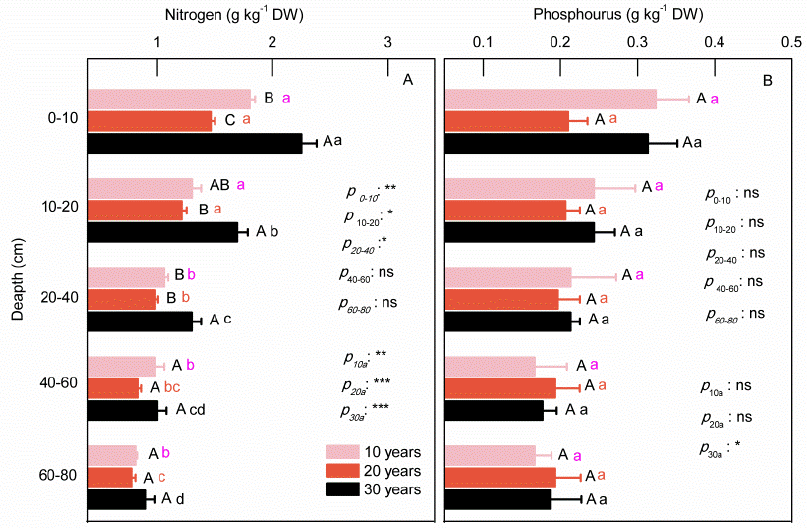
Figure 2. Concentrations of soil total nitrogen ( A ) and total phosphorus ( B ) of all Chinese fir plantations. The uppercase letters on the bars indicate significant difference between different aged plantations in the same soil layer, while the lowercase letters indicate significant difference among soil layers (0–10, 10–20, 20–40, 40–60, and 60–80 cm) in plots with same age. *, **, ***, and ns were indicated p < 0.05, p < 0.01, p < 0.001, and no significance, respectively.